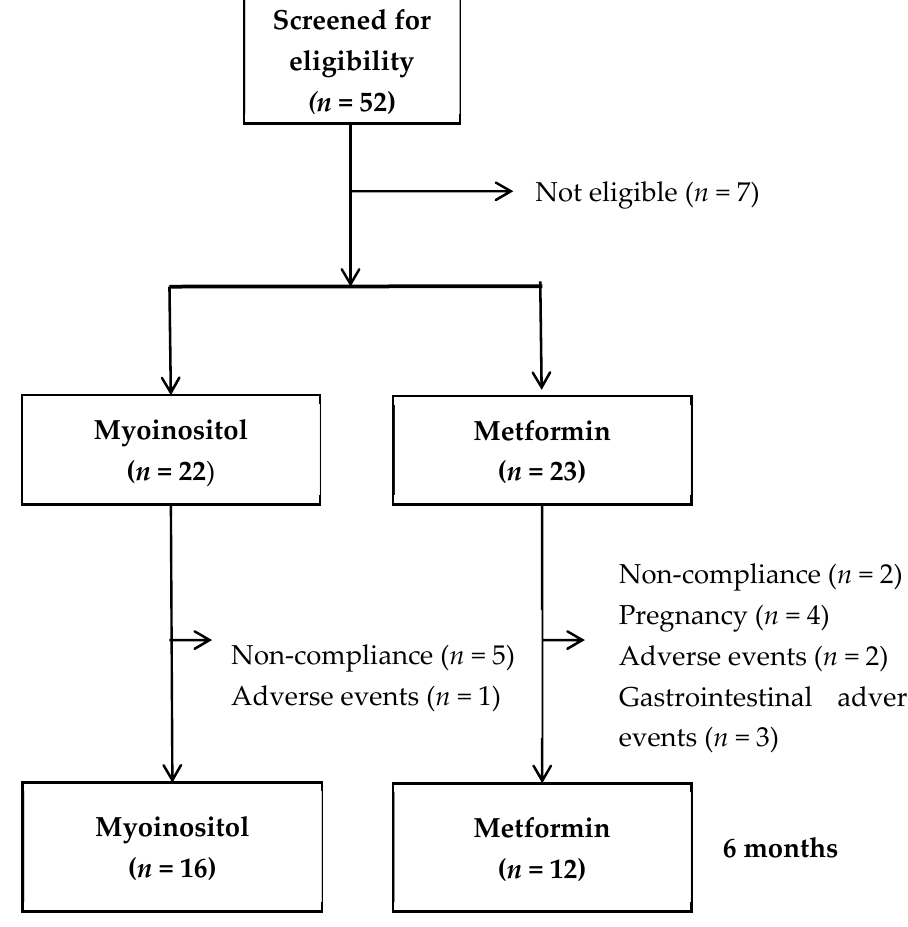
Figure 1. Flowchart of the study.